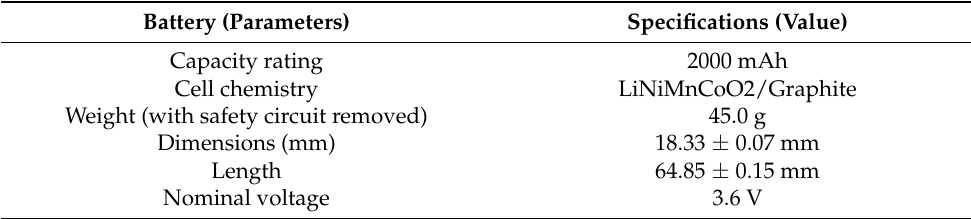
Table 1. Parameters of